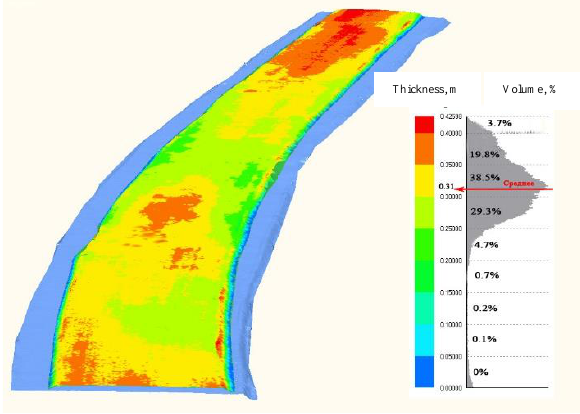
Figure 17 . Distribution of the layer thickness deviations. TLS allows the creation of detailed 3D models in a format that readily can be integrated into road BIM (Fig. 18).